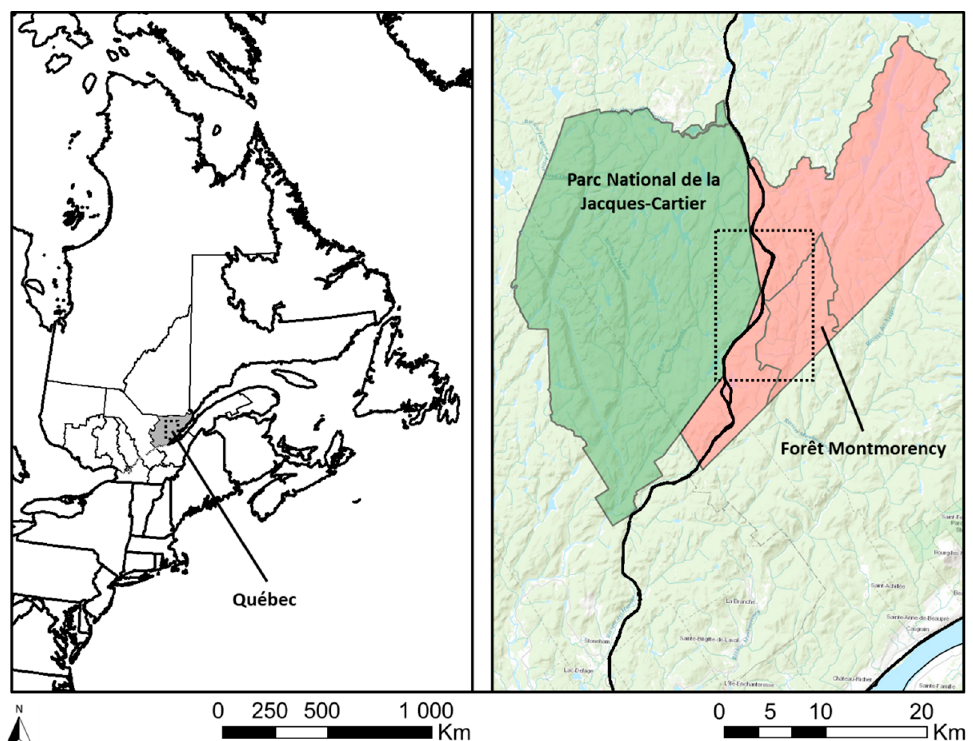
Figure 1. Map showing the study area in Quebec, Canada.